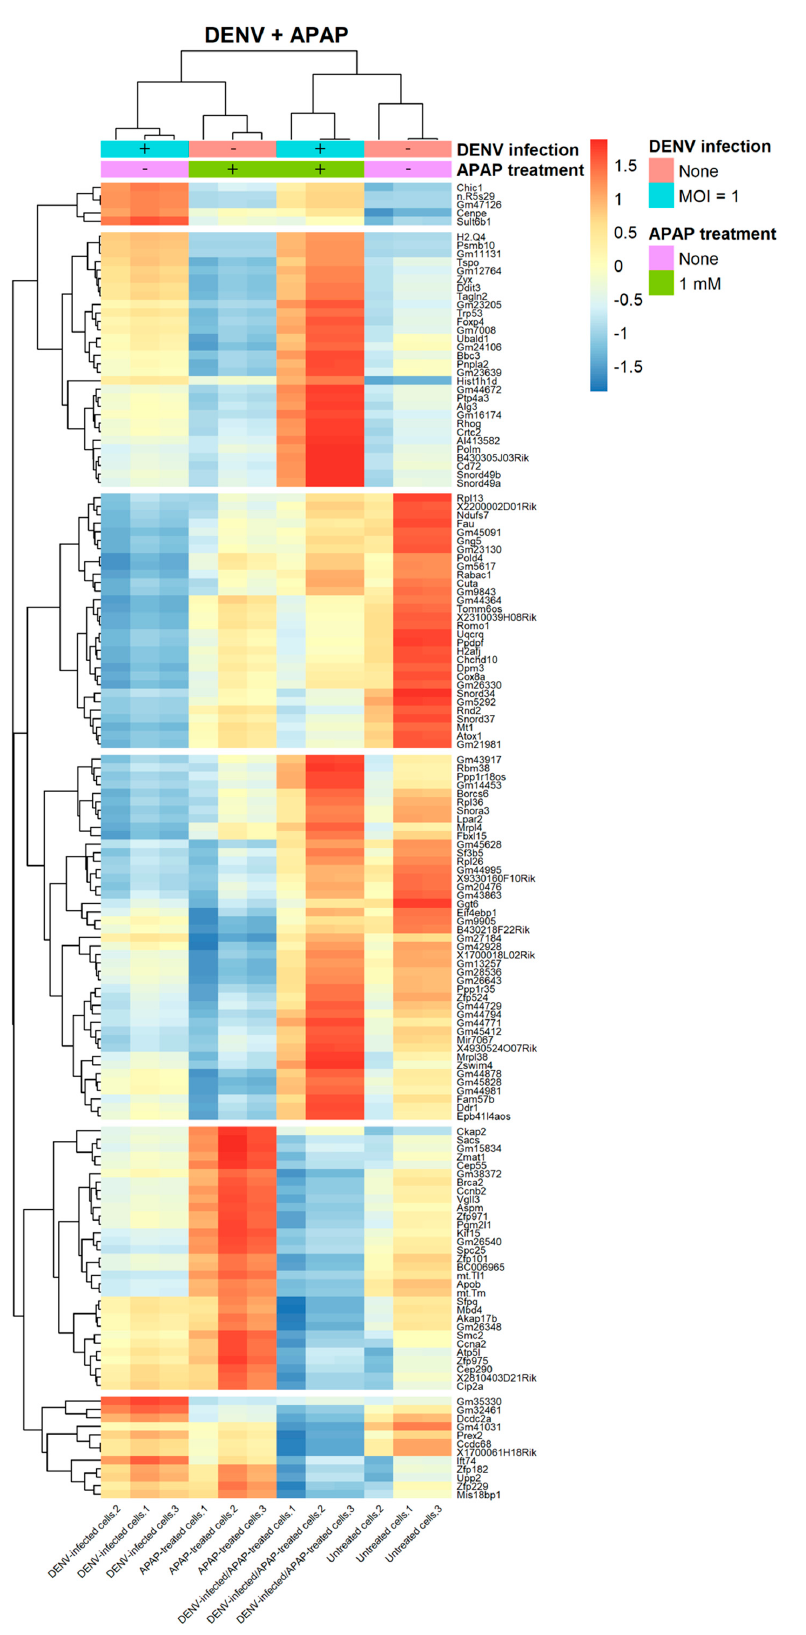
Figure 2. Gene expression patterns of significant DEGs in AML-12 hepatocytes both DENV